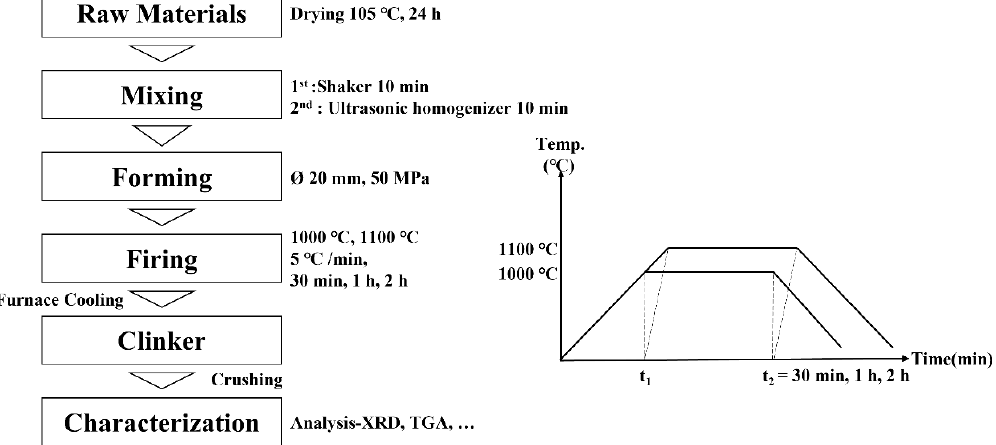
Figure 1. Schematic diagram of experimental procedures.